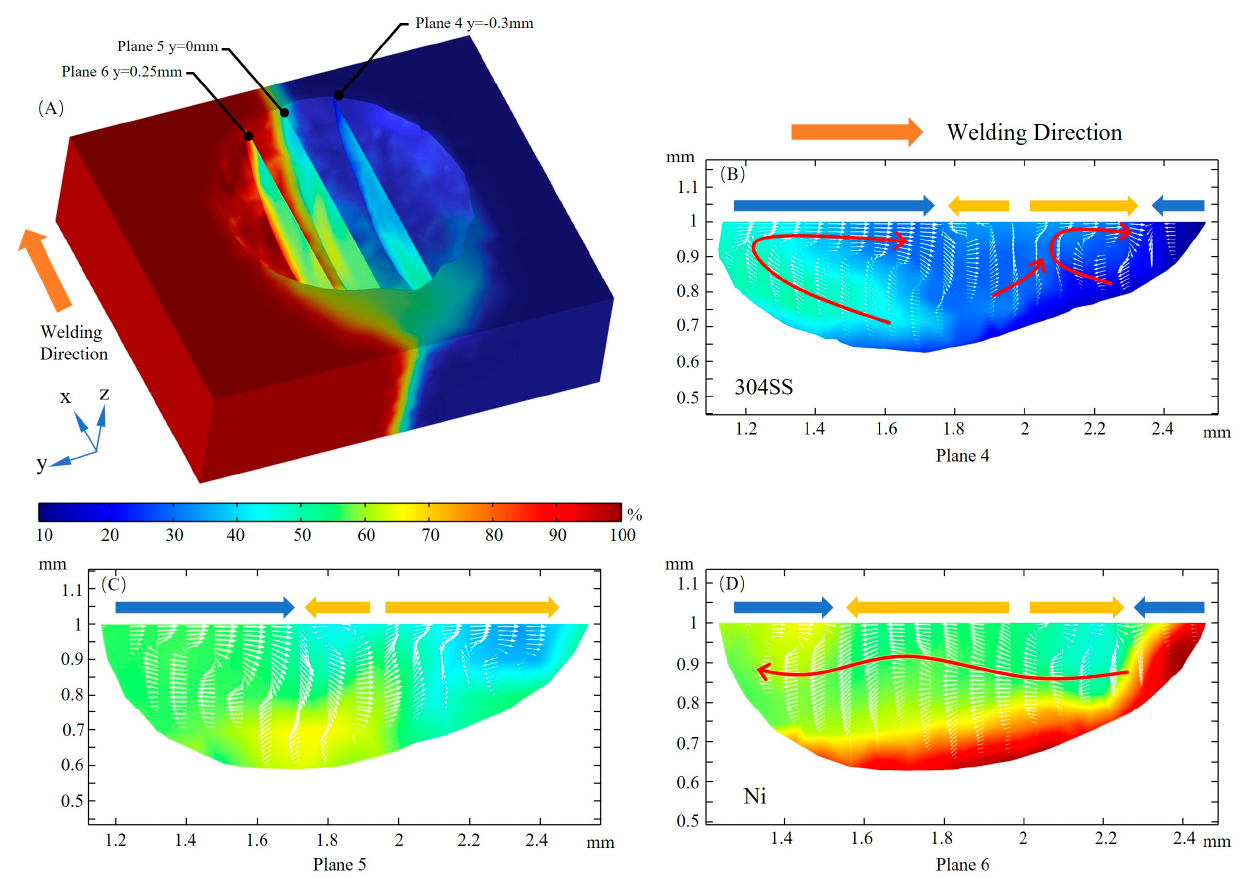
Figure 13. Ni concentration on xz sections. ( A ) 3D view; ( B ) y = − 0.3 mm; ( C ) y = 0 mm; ( D ) y = 0.25 mm.